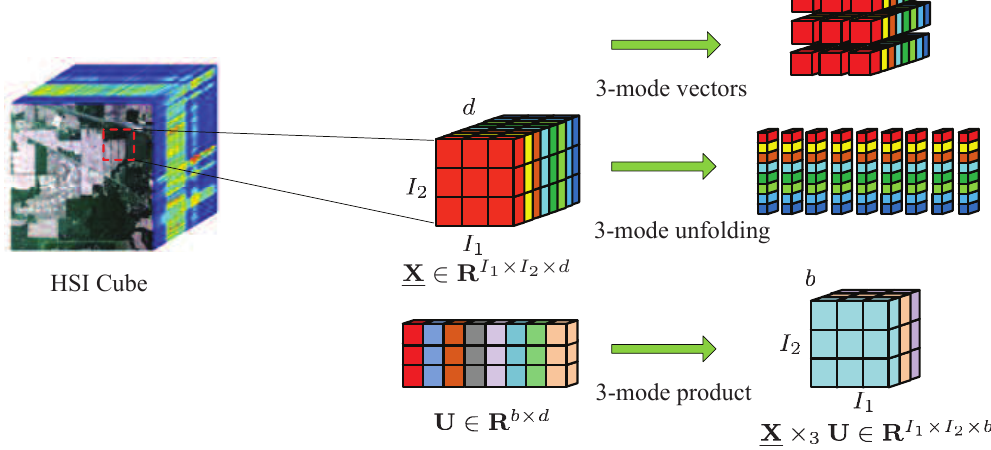
Figure 1. Visual illustration of n -mode vectors, n -mode unfolding, and n -mode product of a third-order tensor from a hyperspectral